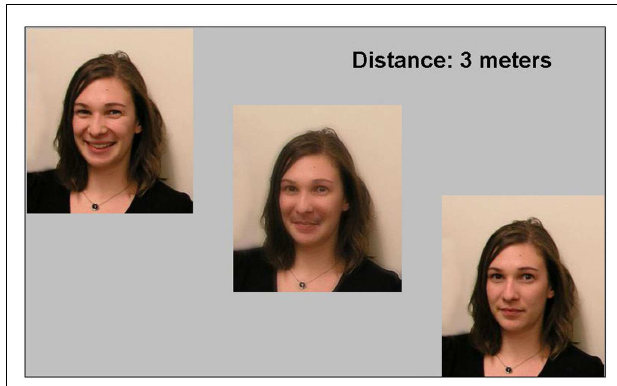
FIGURE 1 | Example display. The hybrid image in the middle is composed of the left image (in the low spatial frequencies) and the right image (in the high spatial frequencies). Observers had to stand at the distance indicated and judge whether the hybrid looked more like the left or right component image using a keypad. Because of the human contrast sensitivity function (see Appendix), when viewing this hybrid from close up it should look like the right image; when holding it far away or squinting it should look like the left component